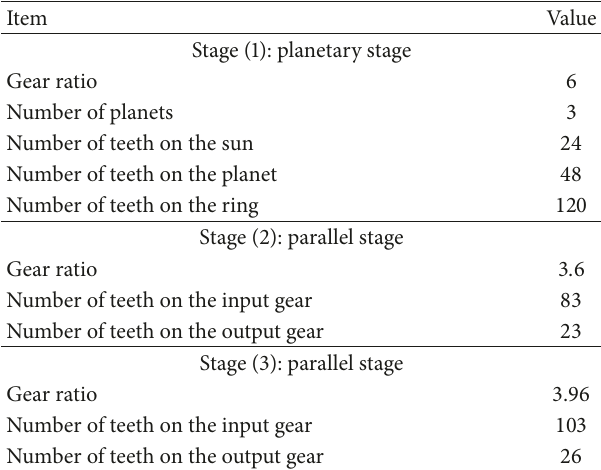
Table 2: Preliminary size of the planetary